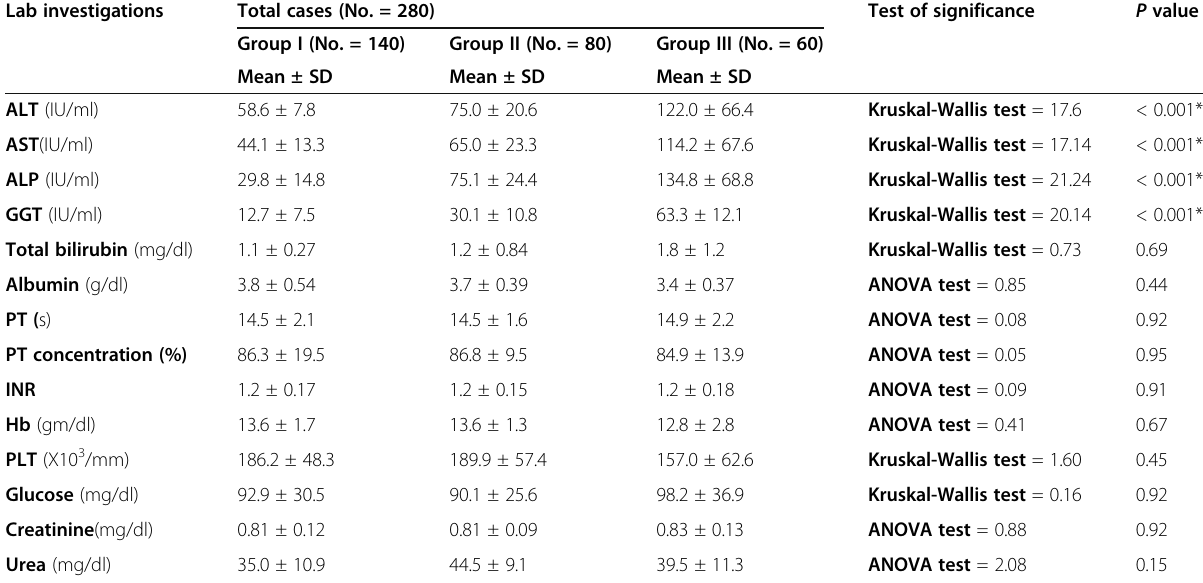
Table 1 Baseline routine and specific laboratory investigations of the studied groups Lab investigations Total cases (No. = 280)